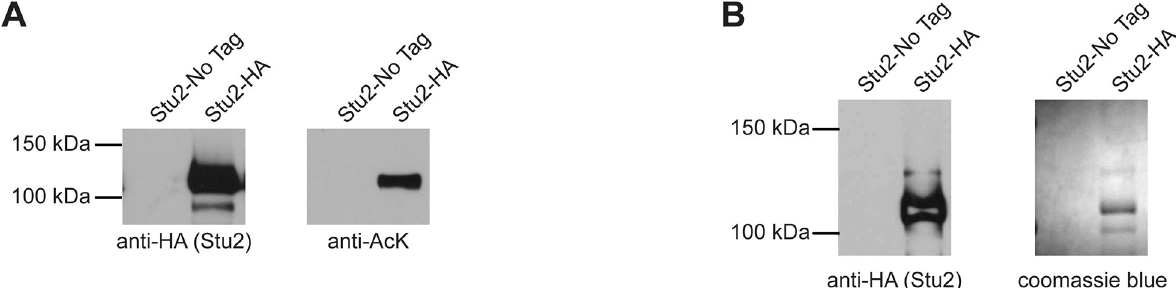
Fig 1. Stu2 is acetylated. Yeast extracts containing Stu2-HA (yRM12358) or untagged Stu2 (yRM12359) were immunoprecipitated with anti-HA magnetic beads and immunoblotted with mouse anti-HA and rabbit anti-AcK. (B) To identify protein bands for analysis by ms/ms mass spectrometry, Stu2-HA was immunoprecipitated with anti-HA magnetic beads. Pull-downs were separated by SDS-PAGE and either immunoblotted with mouse anti-HA to identify the Stu2-reactive bands or stained with coomassie blue R-250. The corresponding coomassie blue bands were